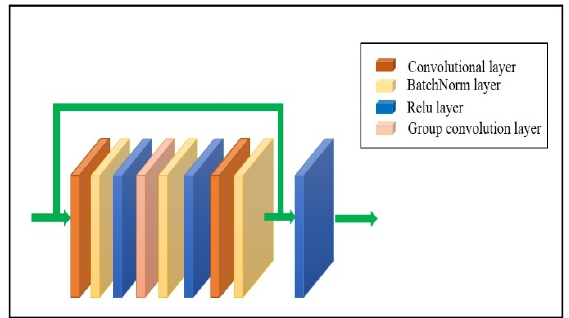
Figure 6. The overview of ResNet blocks. It consists of two convolution layers (1 × 1 × 1 kernel size), one group convolution layer (3 × 3 × 3 kernel size), and three batch normalization (BatchNorm) layers and rectified-linear unit (ReLu) layers.